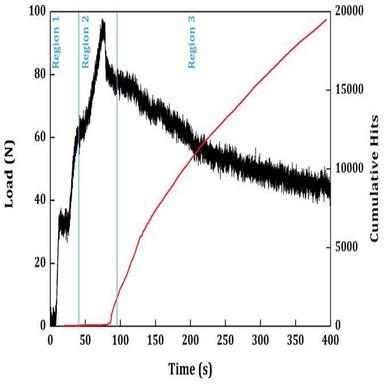
Load vs Time and Cumulative Hits vs Time for Specimen B.